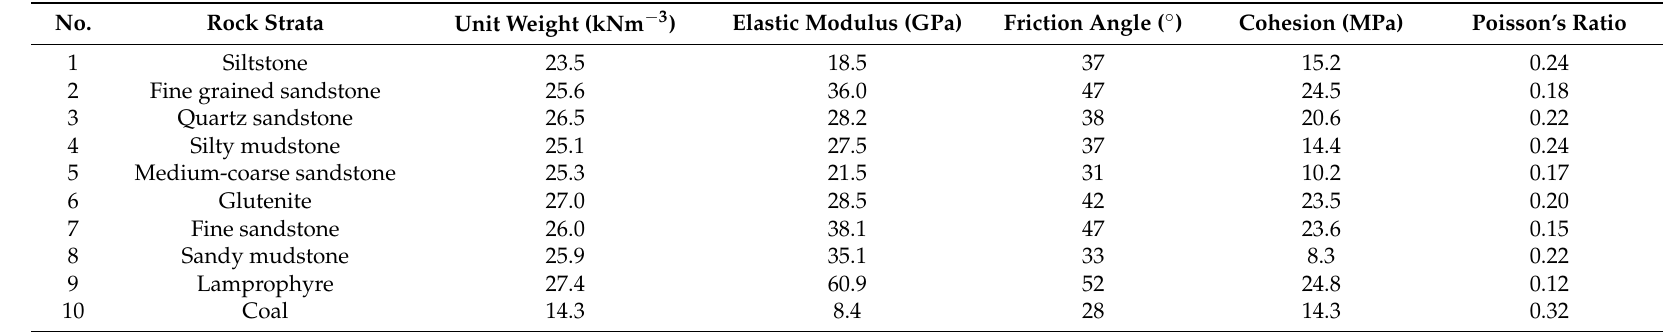
Table 1. Physical and mechanical properties of overlying rock